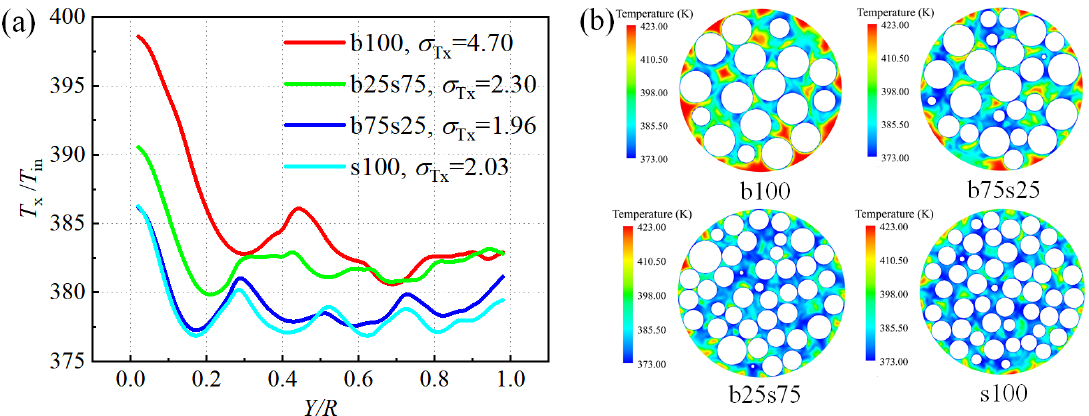
Figure 20. ( a ) Relative radial temperature distributions in different packed beds; ( b ) 2D radial temperature distributions at section-3 in different packed beds.